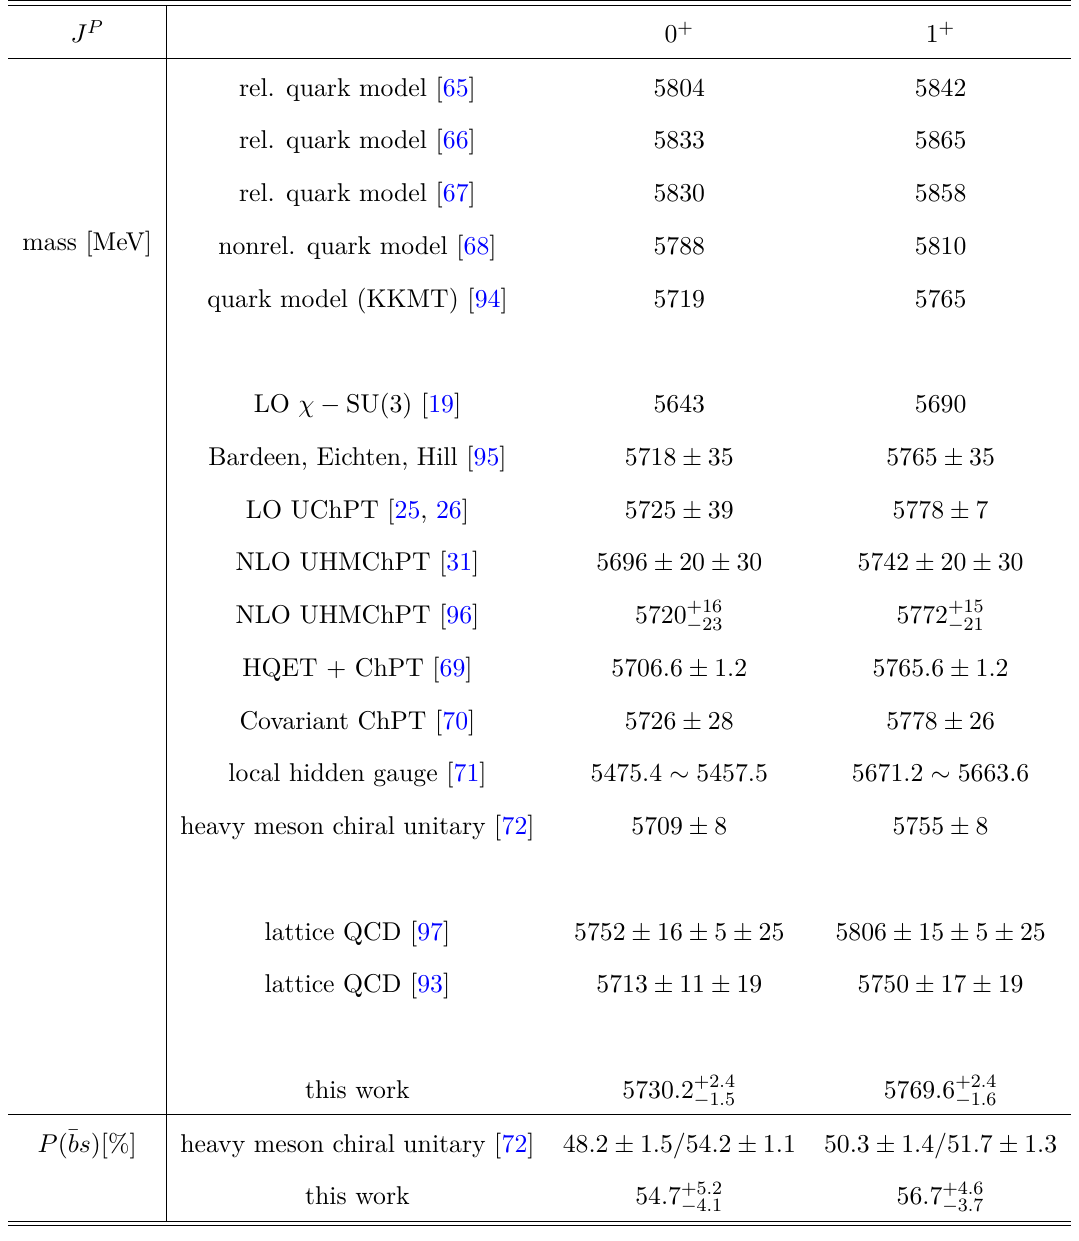
Table 3 . The comparison of the B s pole masses (MeV) and the contents of bare cores extracted in this work with those from other theoretical works and lattice QCD. In this work, the content of the bare ¯ bs cores in the B s states, denoted as P (¯ bs ) , is extracted at L = 5 fm. The errors on our masses and probabilities are obtained from the errors of the parameters in eq.